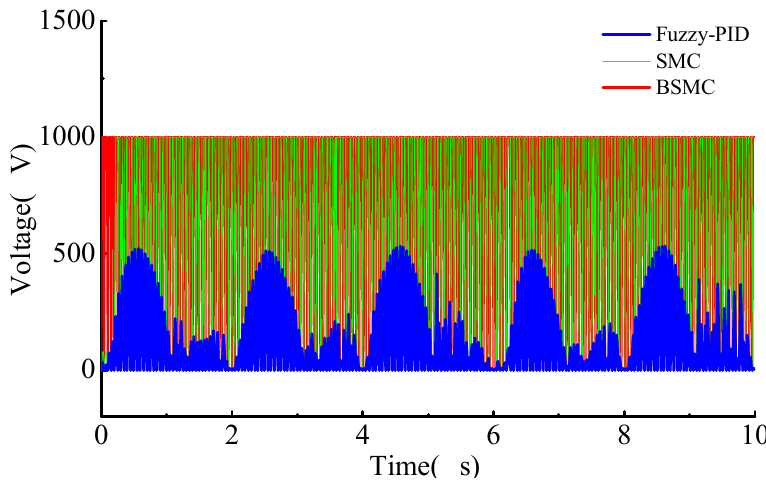
Figure 3. Input voltage of the piezoelectric stack.